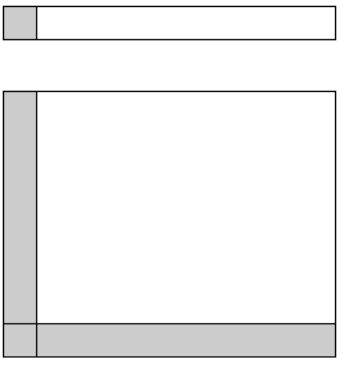
Figure 3. 1D ( top ) and 2D ( bottom ) set of measurements (in white), and their corresponding boundary conditions (in grey).